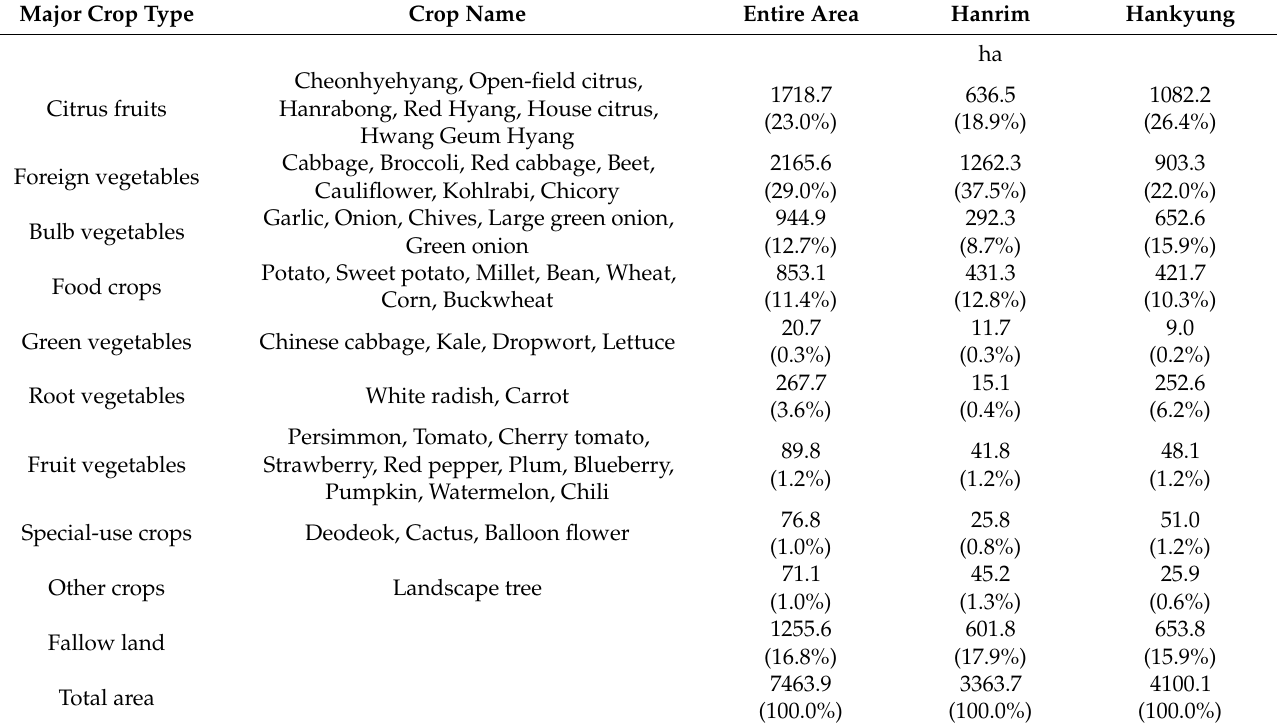
Table 2. Cultivated crops and area in the Hankyung and Hanrim study